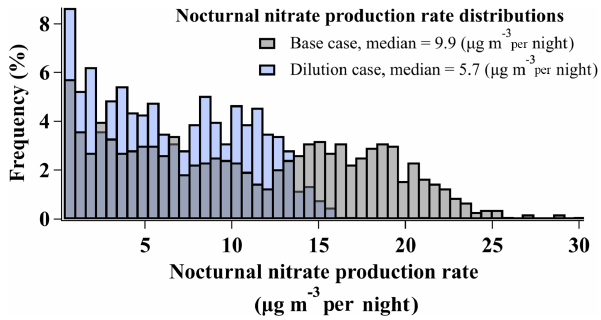
Figure 9. Histograms of nocturnal nitrate production rates (µgm − 3 per night) predicted by base case simulations and simulations in- corporating a first-order dilution loss process with rate constant k dilution = 1 . 3 × 10 − 5 s − 1